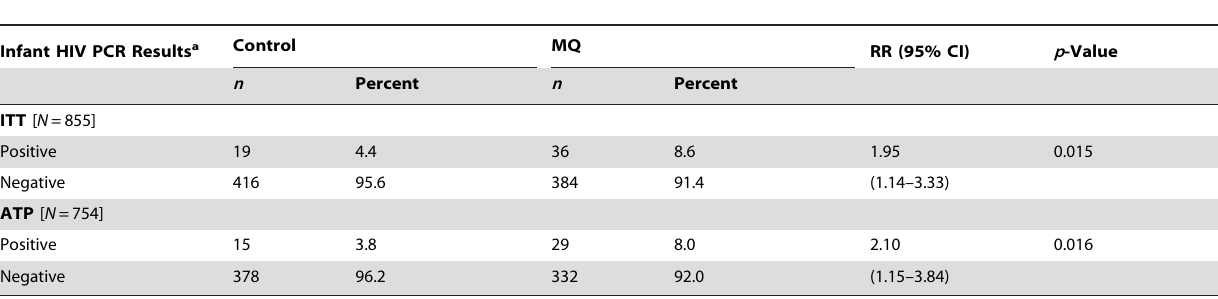
Table 10. Mother to child transmission of HIV by treatment